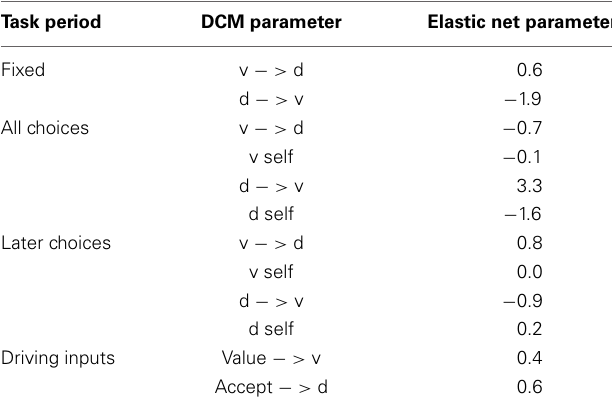
Table 7 | Regression coefficients predicting log(k) as a function of DCM